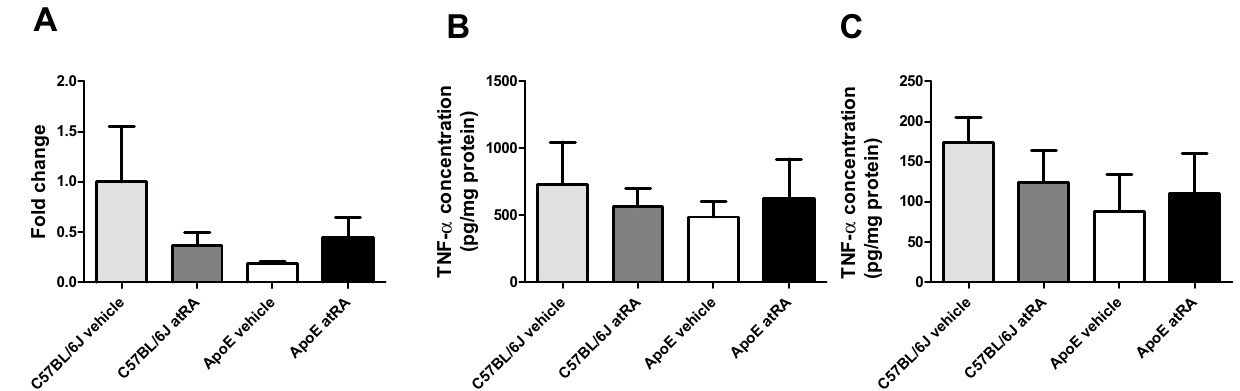
Figure 5. The all-trans-retinoic acid treatment did not affect TNF-α synthesis and secretion by perivascular adipose tissue. ( A ) mRNA TNF-α level in perivascular adipose tissue. ( B ) TNF-α concentration in perivascular adipose tissue. ( C ) TNF-α concentration in the conditioned medium after 24 h incubation with perivascular adipose tissue explants. All-trans-retinoic acid (5 mg/kg/day) or vehicle (corn oil) were administered orally by plastic feeding tubes to Apo-E and C57BL/6J mice for 8 weeks. Data are shown as mean ± SEM of 5–6 mice per group. The results were analyzed by one-way ANOVA with Tukey’s Multiple Comparison Test.